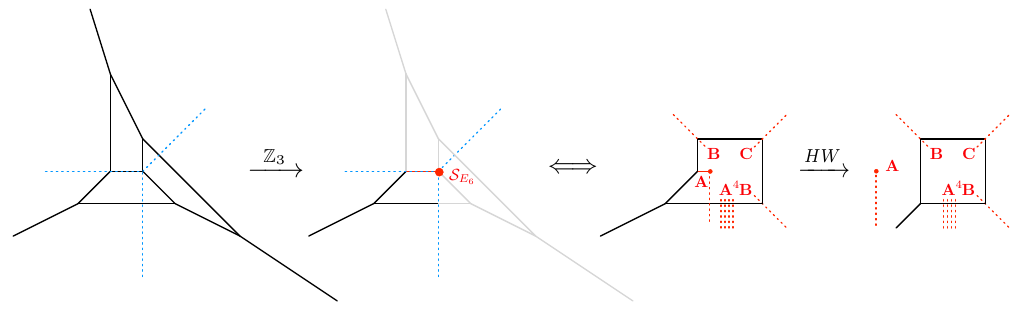
Figure 23 . The Z 3 quotient of a rank-3 non-Lagrangian theory, B 4 , leading to SU(2) + 4 F .